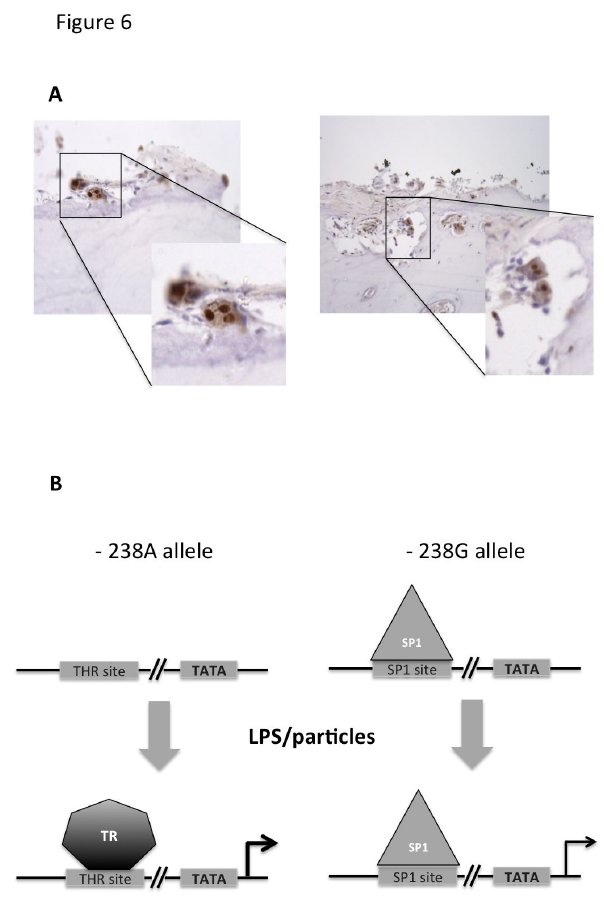
TNF promoter activation. Panel A: Photomicrographs of osteolysis interface membrane-bone sections representative patients (total n=6) and stained for anti-thyroid TR-α1 and TR-α2, demonstrating nuclear staining of osteoclasts lying on bone surfaces. Panel B: LPS induced activation of the -238A TNF promoter allele is facilitated by the binding of TR. In contrast, the SP1 site in the -238G allele could be occupied by SP1 even in the absence of TLR stimulus, resulting in a less inducible expression of the TNF